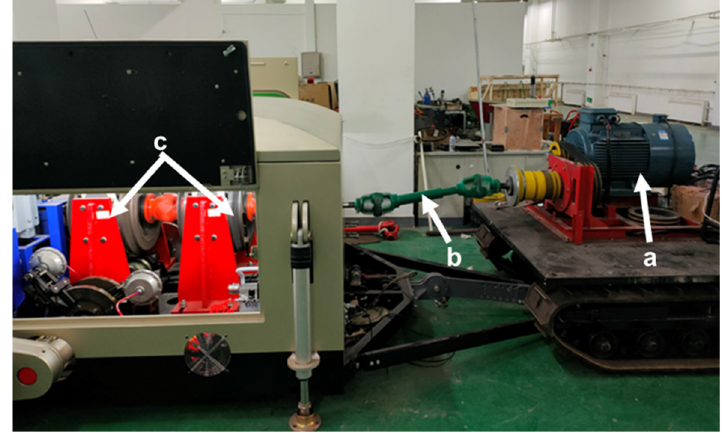
Figure 11. The loading test site. ( a ) 37.5 kW motor; ( b ) universal joint connection shafts; ( c ) eddy current dynamometer. Table 6. The parameters of the test equipment.